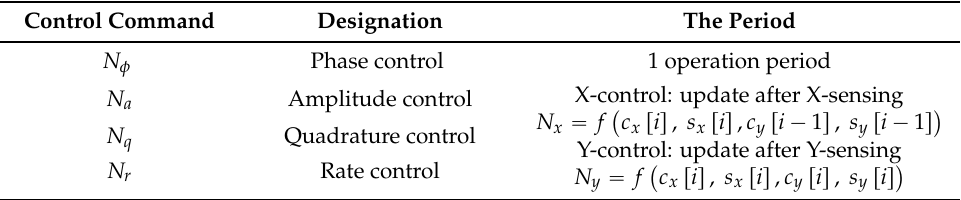
Table 4. The update period of control commands.